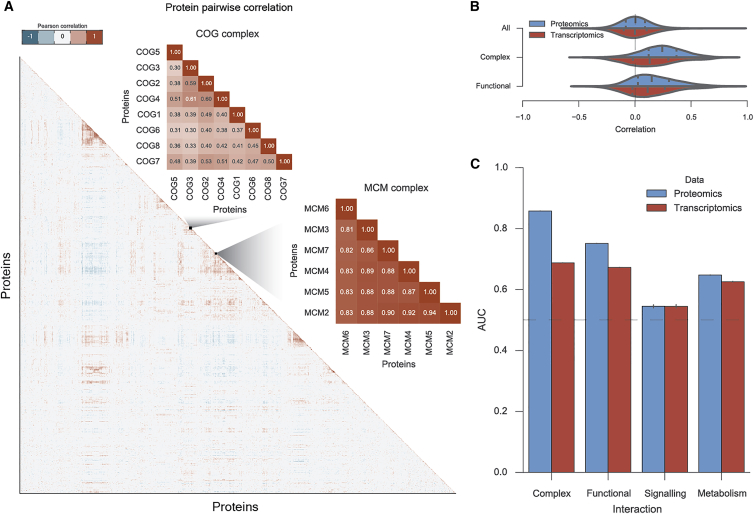
Copy-Number Variation Attenuation for Protein Complex Subunits Results in Strong Co-regulation of Their Abundances across Samples(A) Protein-protein correlation matrix using Pearson correlation coefficient and two representative cases of top correlated protein complexes.(B) Distribution of all protein-protein correlations at the protein level (proteomics) and transcript level (transcriptomics). Protein interactions within complexes are represented by the complex label, and protein functional interactions, which are not necessarily direct, are represented by the functional label.(C) Enrichment analysis by the means of the area under the receiving operating characteristic curves (AROC) using pairwise correlation coefficients, for both proteomics and transcriptomics measurements. Error bars display the variability obtained with five randomized true negative sets.